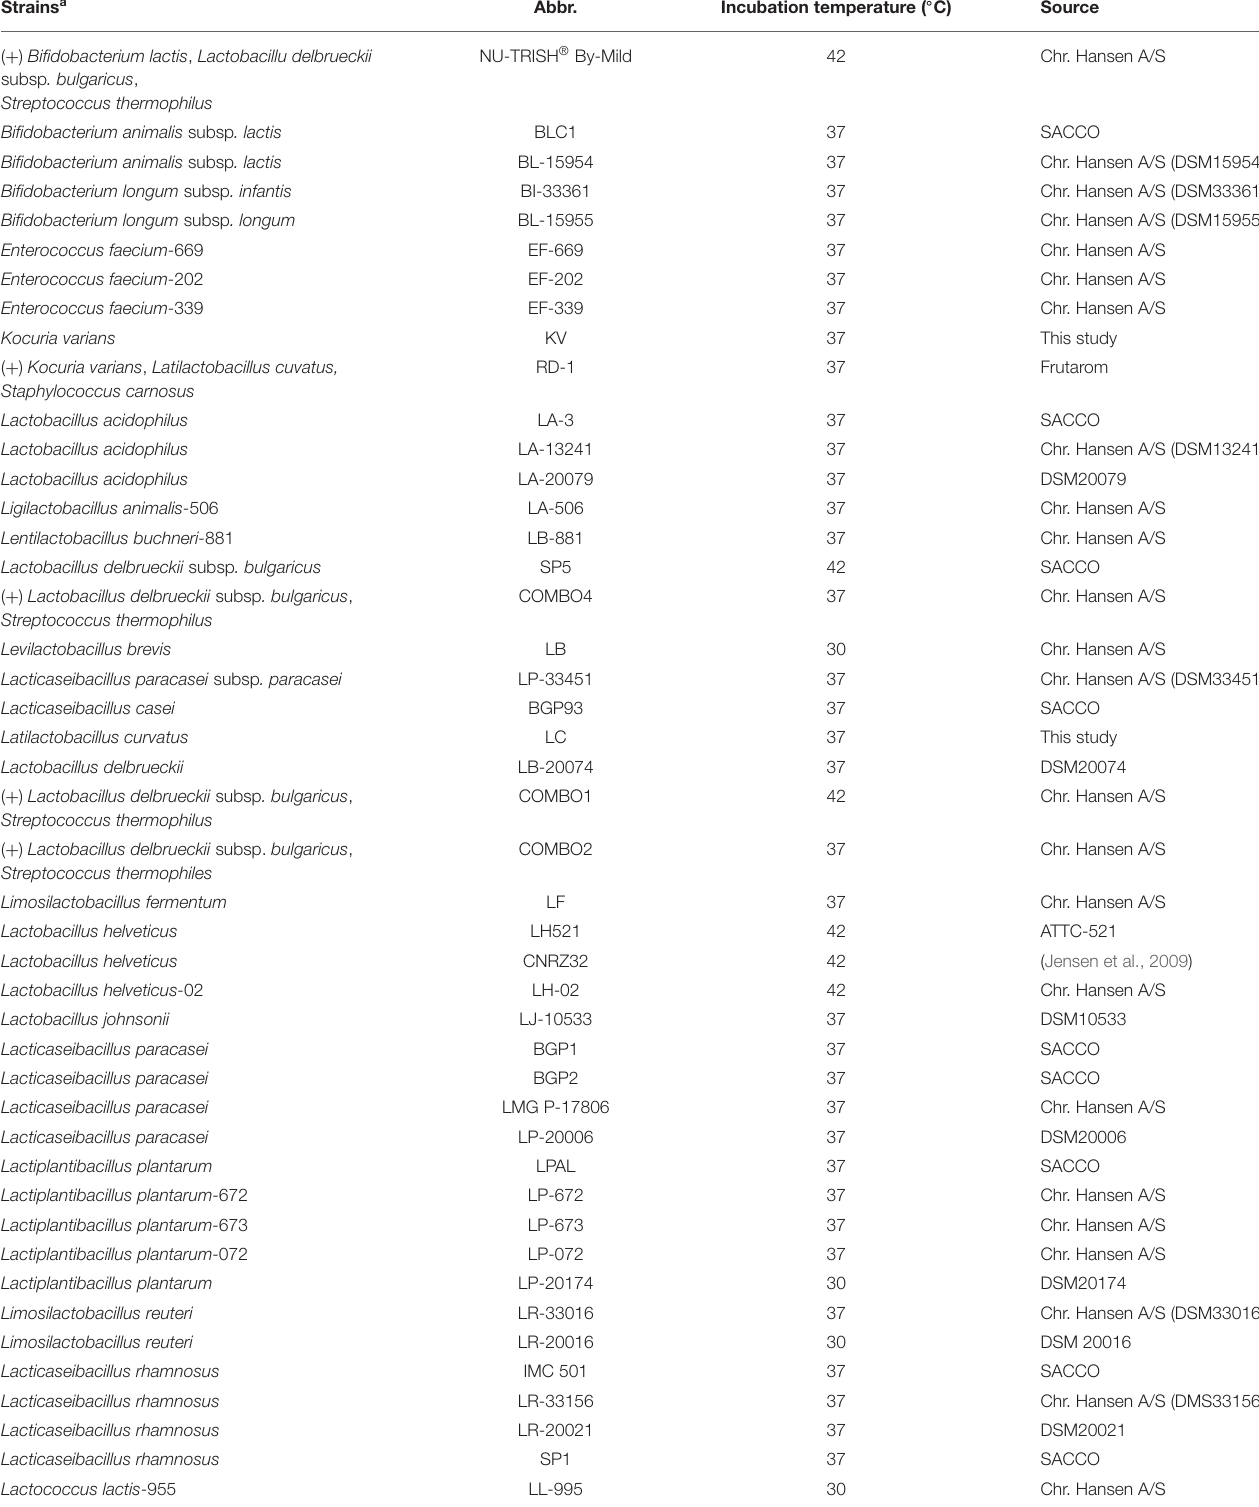
TABLE 2 | Lactic acid bacteria strains used in this study. Strains